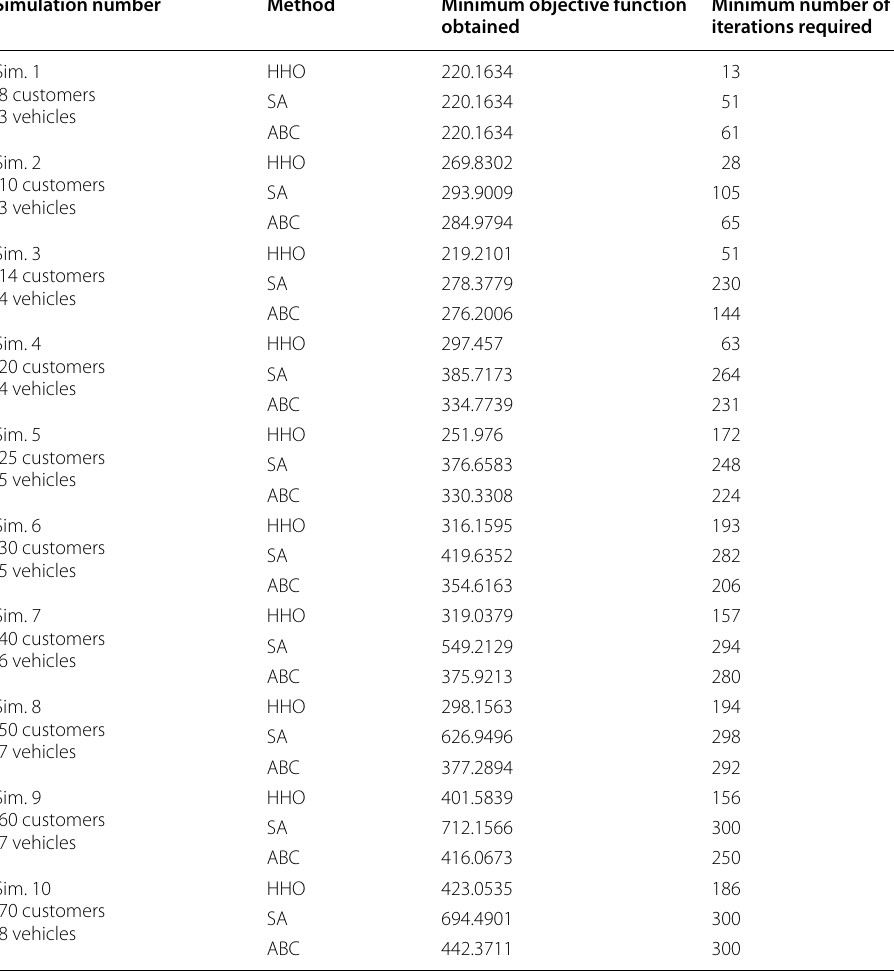
Table 3 Comparison of HHO, SA and ABC for VRP Simulation number Method Minimum objective function